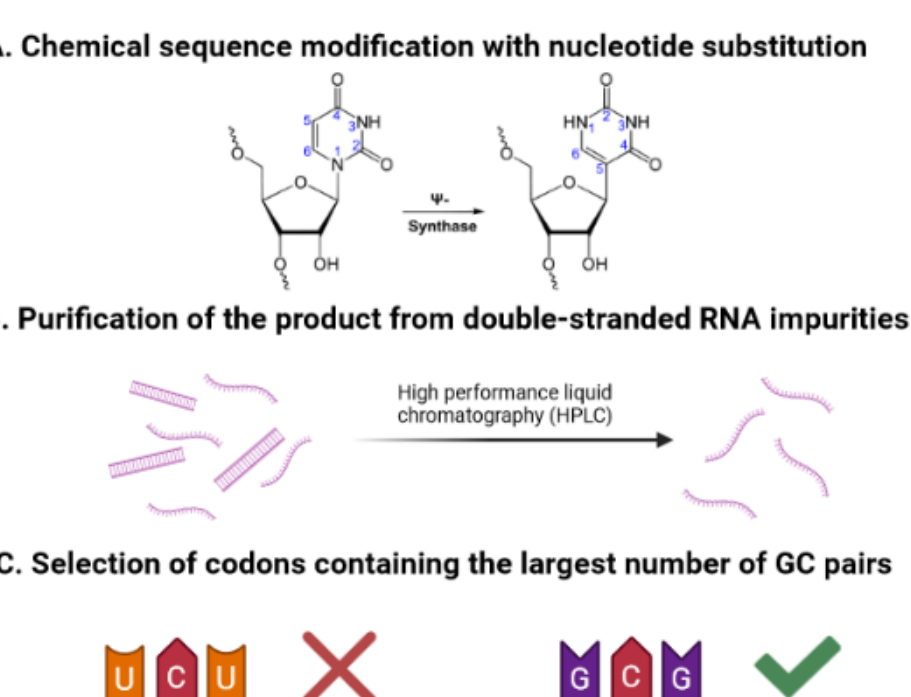
Figure 2. Methods of mRNA nuclease degradation reduction. The chemical modification of uridine to pseudouridine ( A ), purification of the product from double-stranded RNA using high-performance liquid chromatography (HPLC) ( B ), and choice of codons containing more G:C pairs ( C ) are performed to reduce the sensitivity of mRNA to digestion by nucleases.